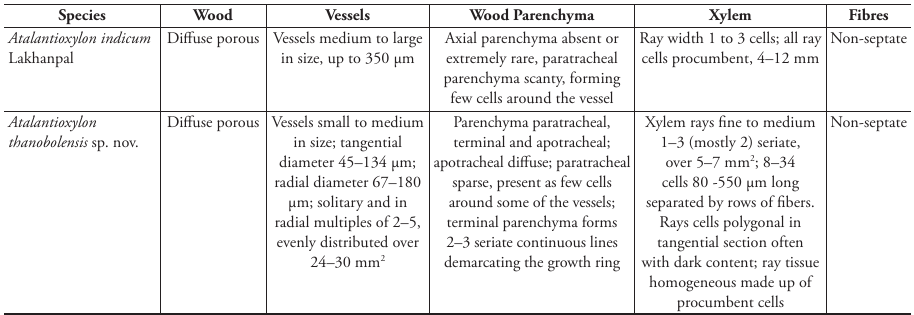
Table 1. Comparison of the new species with Atalantioxylon indicum Lakhanpal. Species